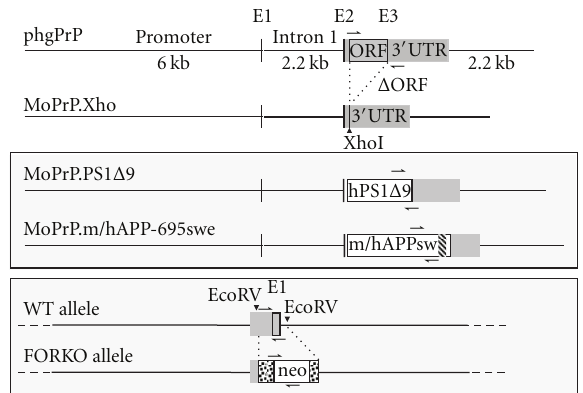
Figure 1: Generation of chimeric mice. A construct used to gen- erate chimeric mice expressing human APP with Swedish mutation and hypoestrogenism due to the absence of FSH receptor. A murine prion protein (PrP) genomic fragment was modified to obtain the vector phgPrP [21]. A region containing 6kb of promoter, exon 1 (noncoding), intron 1, and exon 2 (non-coding) was fused to the third and last exon (2008bp) and 2.2kb of downstream sequence. The subsequent removal of the PrP open reading frame (ORF) generated the vector MoPrP.Xho, in which the cDNA encoding PS1 lacking the exon 9 (amino acids 290–319) was subcloned [44]. Finally, the region encoding residues 592 to 622 from the mouse APP-695 cDNA was substituted by the corresponding human one (hatched area), which contains the Swedish KM to NL double mutation and the A β 42 coding sequence. The resulting hybrid mouse/human cDNA was subcloned in MoPrP.Xho [11]. Half arrows indicate the position of the primers used for genotyping the mice. For complete inactivation of the FSH receptor gene, a 638bp fragment containing part of the 5 (cid:2) untranslated region, the coding region of exon 1 (101bp), and about 129bp of intron 1 was substituted by a 1.7kb neomycin expression cassette (dotted box) [19]. A multiplex PCR using primers indicated by half arrows was used to genotype the o ff spring [16]. Black boxes: non-coding PrP exons 1 and 2; grey box: coding exon; ORF are